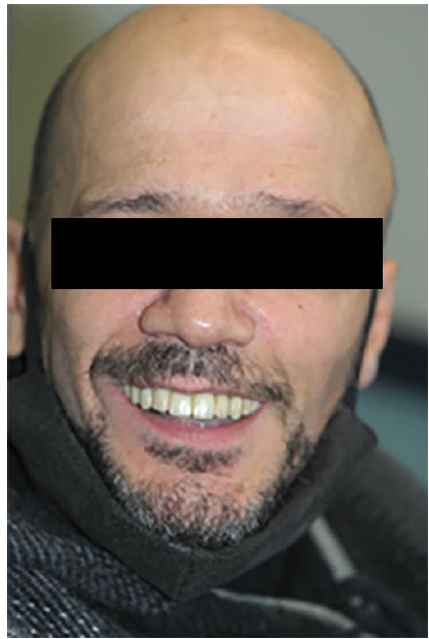
Figure 18. Case 5—Patient wearing DEFS, made of acetal resin.